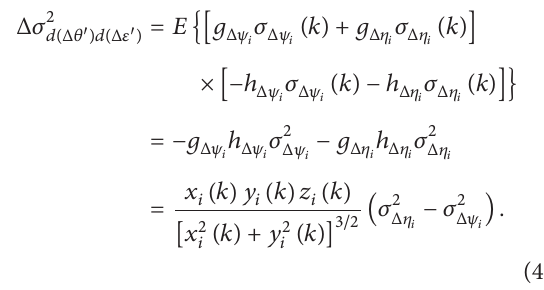
Figure 4: The block diagram of URM.